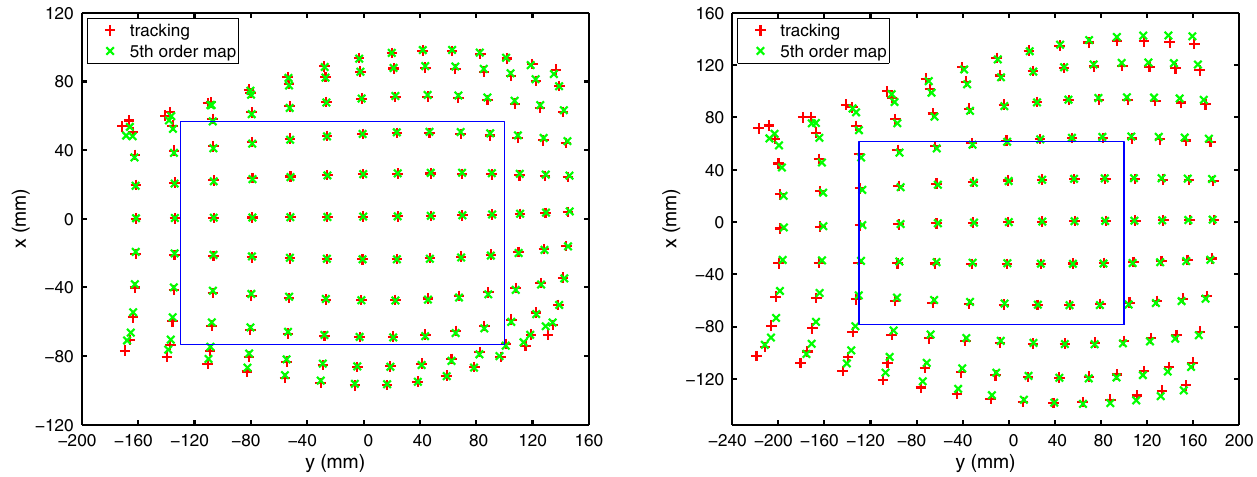
FIG. 19. Tracking is done at Δ p=p ¼ 0 (left) and at Δ p=p ¼ 20% (right). The plots show that brute force tracking and tracking using fifth order map agree very